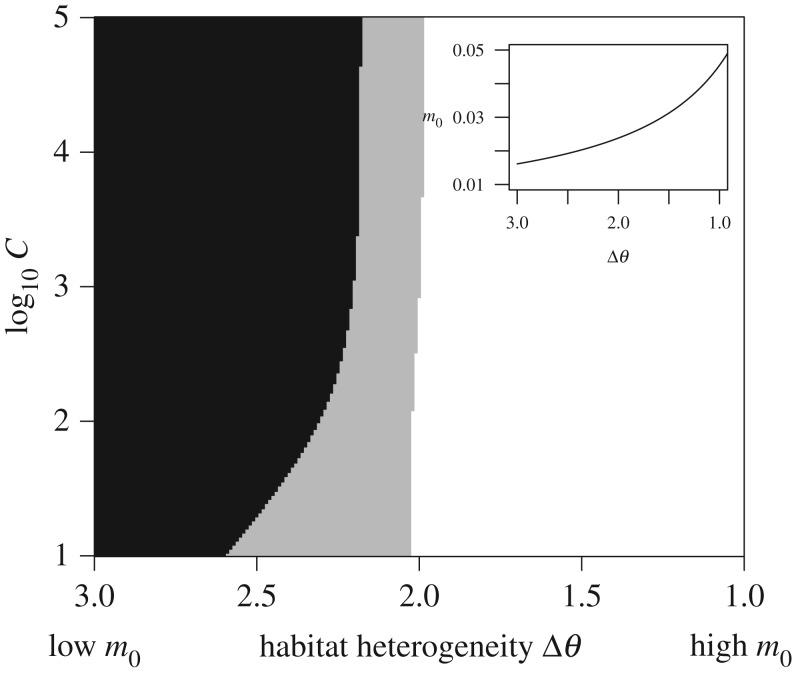
Alternative stable state regimes I (grey) and II (black) as a function of individual straying m0 and the strength of collective behaviour C (note the log10 scale), for the case where individual straying increases with lower habitat heterogeneity (inset). Regime I signifies parameter space where there is either (1) an intermediate-density, symmetric steady state, or (2) an asymmetric dominant/subordinate density. Regime II signifies parameter space where there is an asymmetric dominant/subordinate steady-state density.